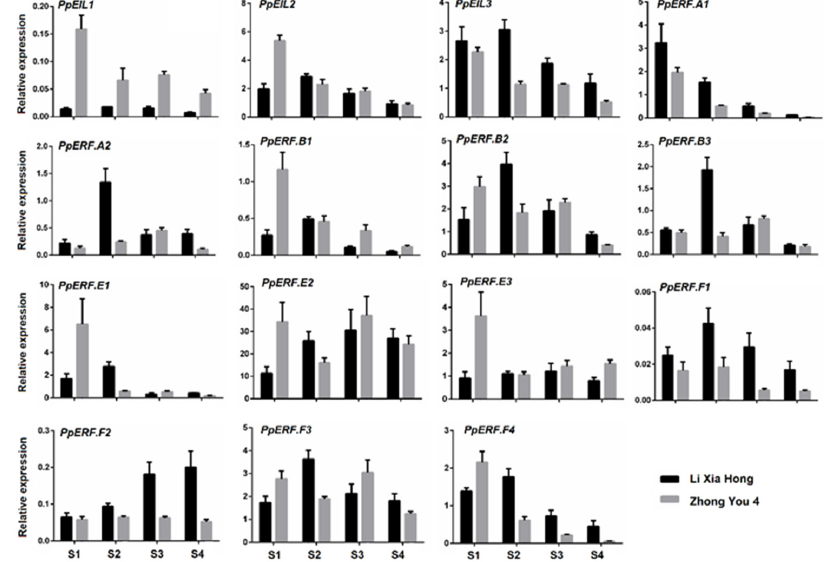
Figure 4. Expression profiles of the PpEILs and PpERFs in fruits of ‘Zhong You 4 ′ and its early ripening bud sport ‘Li Xia Hong’ at different developmental stages. The error bars show standard error (SE) of three biological replicates.